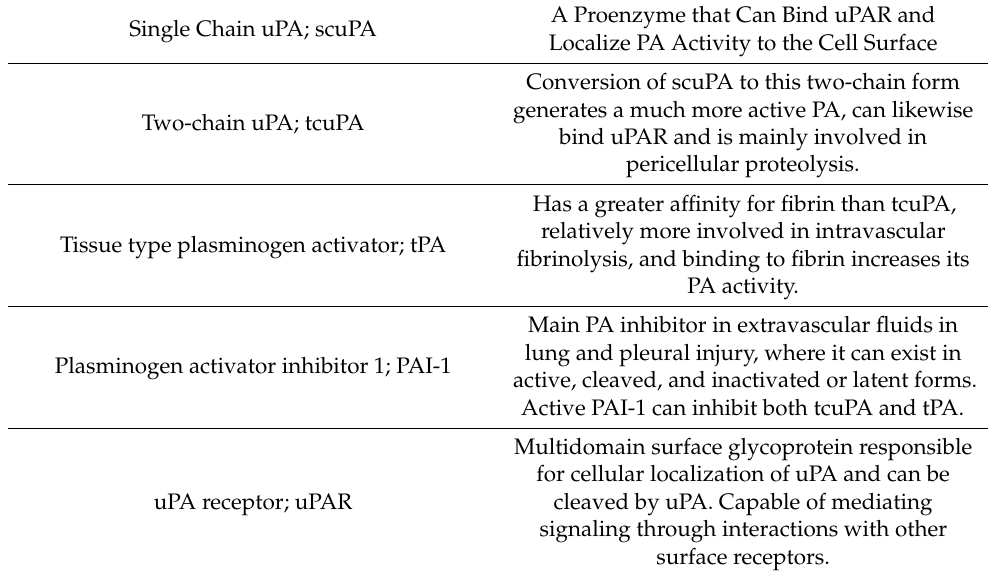
Table 1. Components of the urokinase plasminogen activator (uPA)/uPA receptor (uPAR)